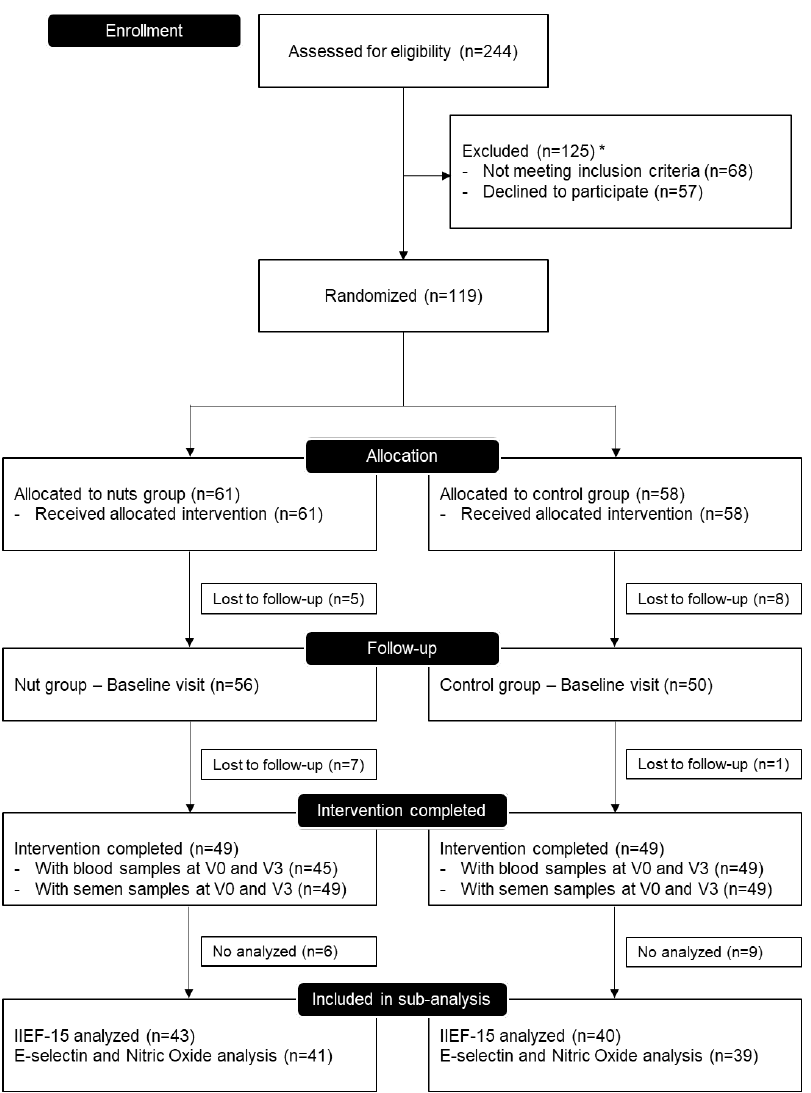
Figure 1. Flow diagram of the FERTINUTS sub-analysis. * 68 participants did not meet the inclusion criteria (ascribed to a non-Western style diet, n = 37; smoking, n = 21; or other minor reasons, n = 10) and 57 subjects declined to participate (lack of interest, n = 34; impossible to contact with them, n = 18; and for non-economic compensation, n = 5).